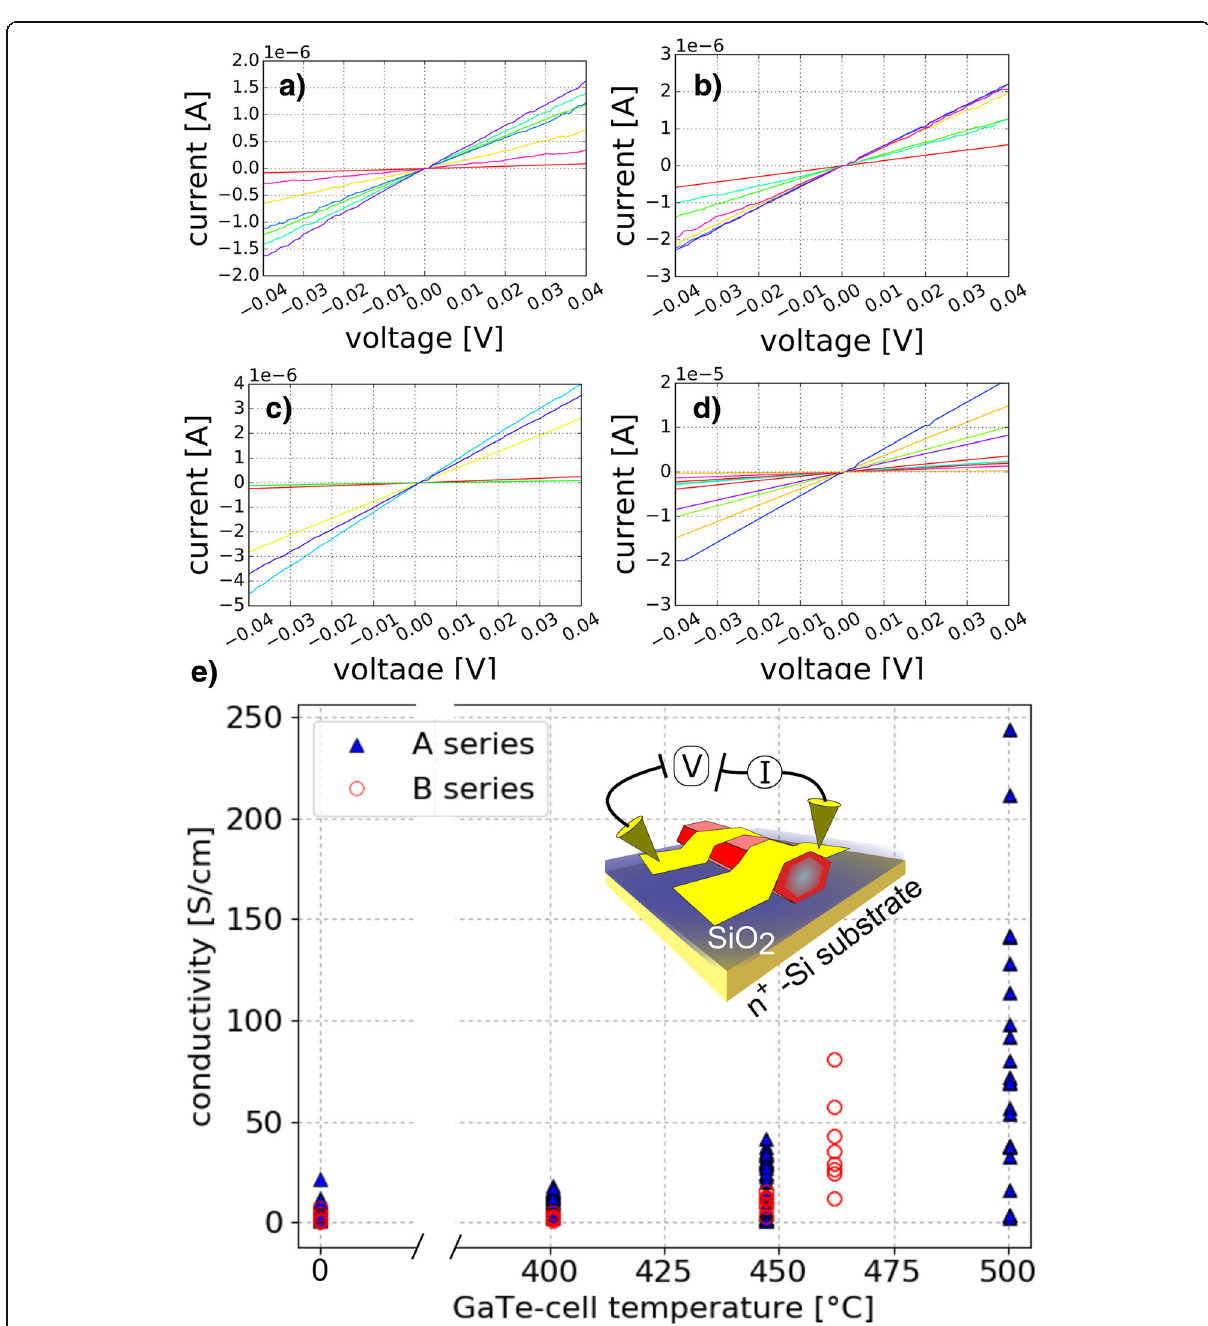
Fig. 6 Electrical characterization. a – d Exemplary I – V measurements of InAs NWs at a GaTe-cell temperature of 0 °C, 401 °C, 447 °C, and 500 °C (series A) measured via two-point contacts. e Determined conductivity values of Te-doped InAs NWs in dependence of GaTe-cell temperature for the A (high As-BEP) and B (low As-BEP) series. The inset shows a schematic of the electrical measurement